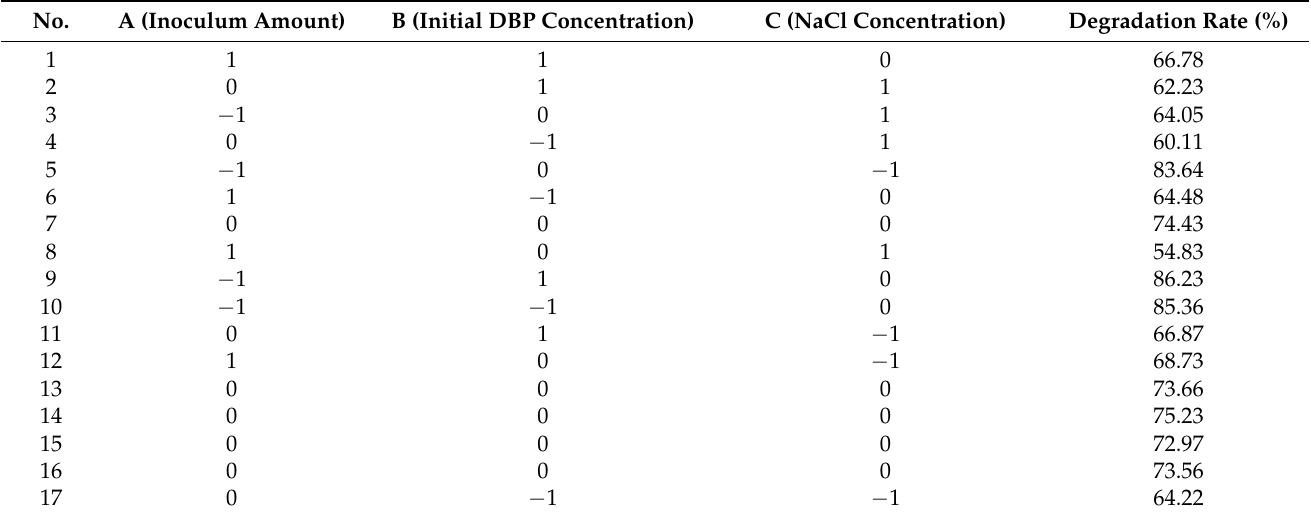
Table 3. The degradation optimization of DP-2 based on Box-Behnken